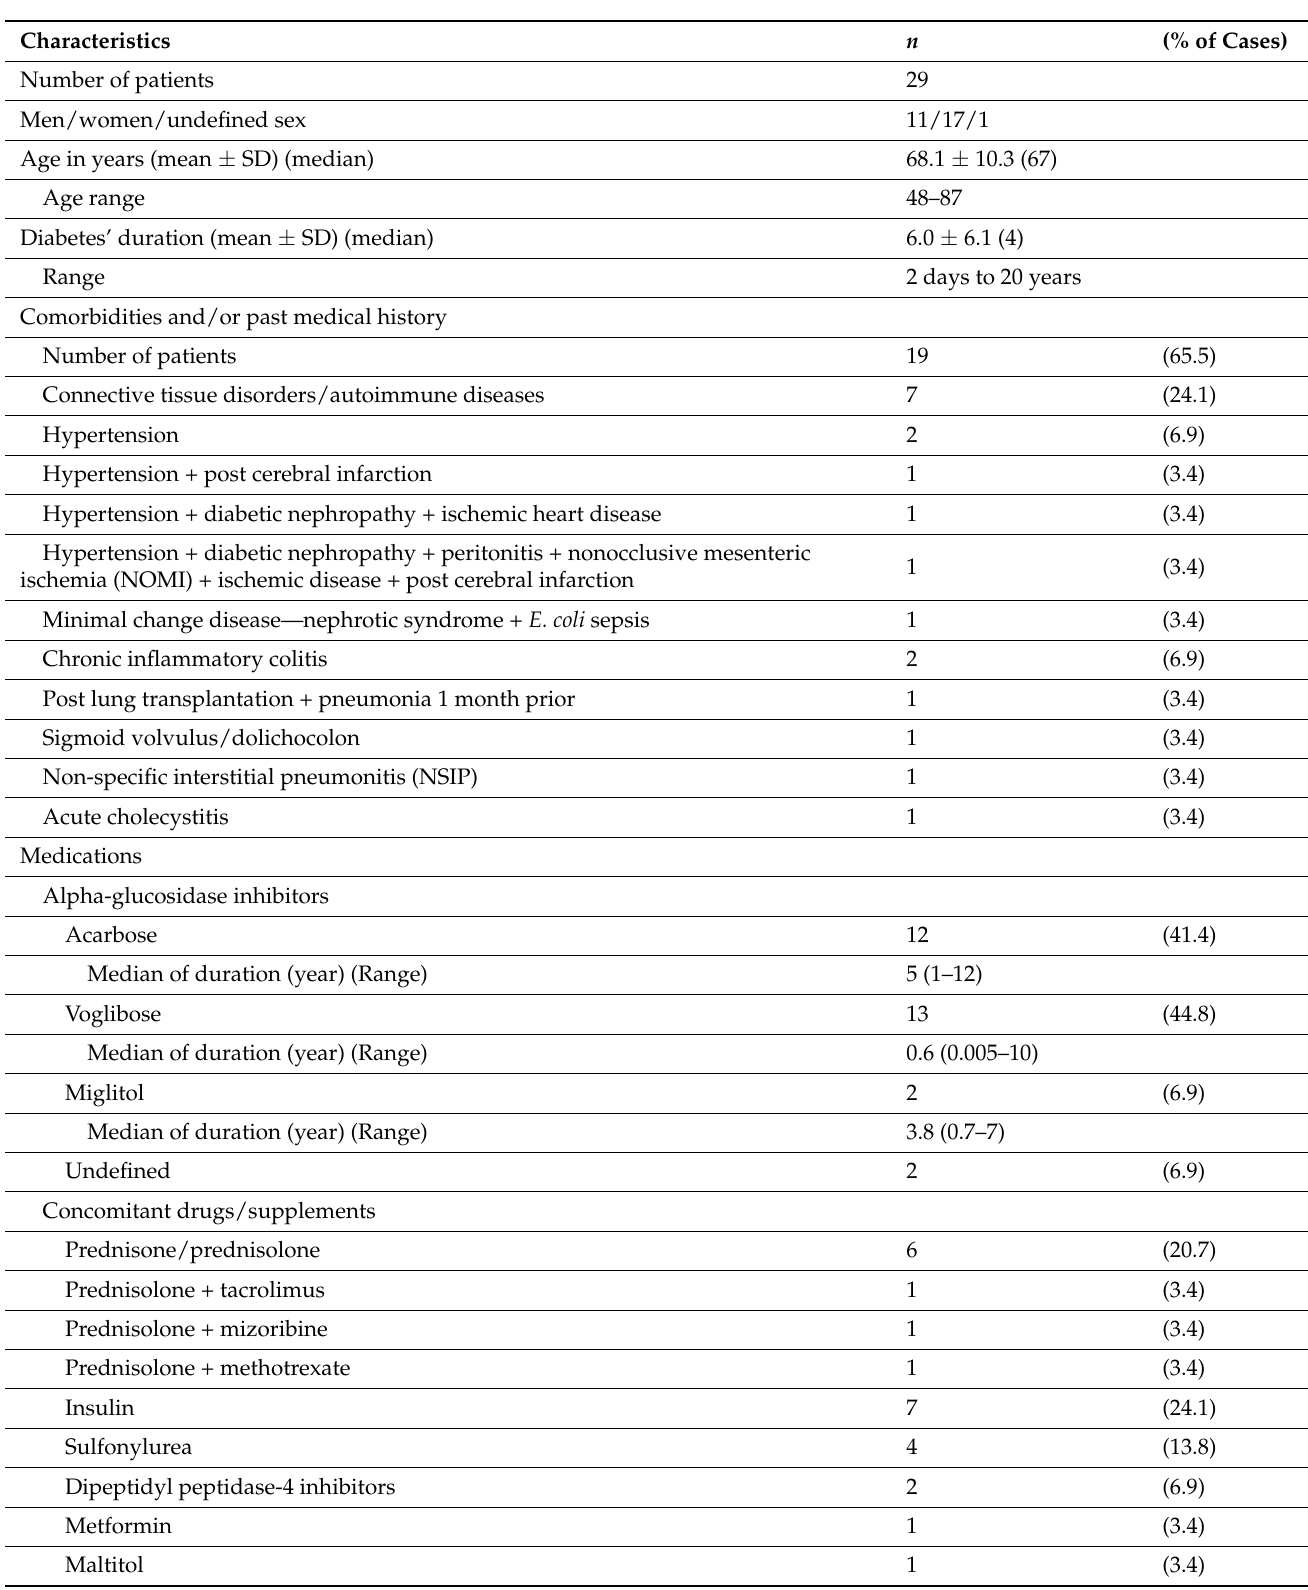
Table 1. Clinical characteristics of patients with pneumatosis